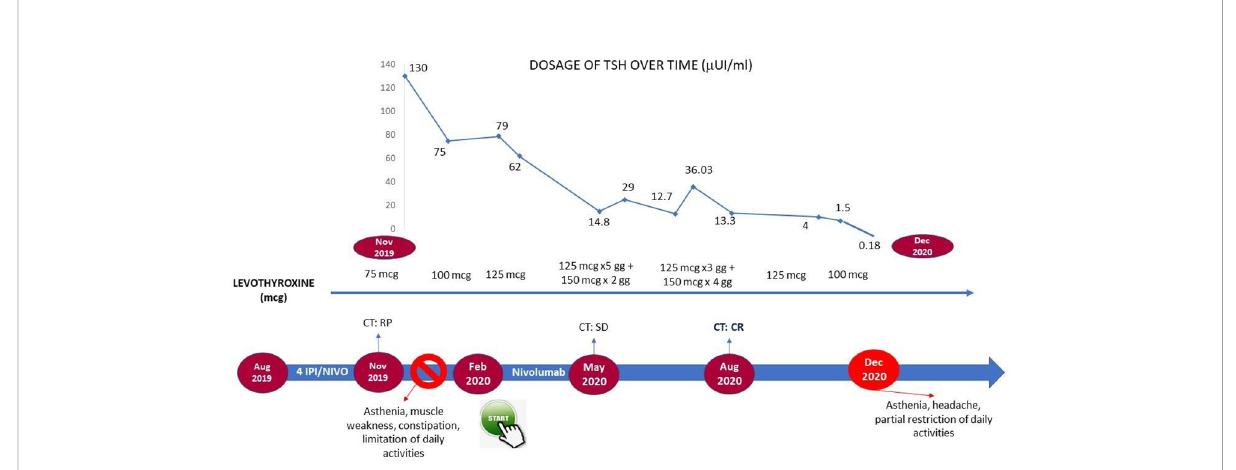
FIGURE 1 Timeline management of cutaneous toxicity in the course of cabozantinib